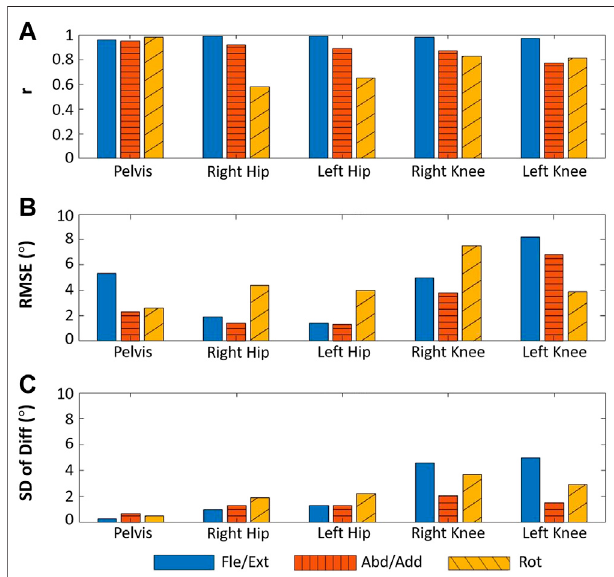
FIGURE 12 | Results for the human subject joint-angle estimation experiment. The blue solid bars denote rotation in the sagittal plane (pelvic tilt, hip Fle/Ext, and knee Fle/Ext), the orange striped bars denote rotation in the frontal plane (pelvic obliquity, hip Abd/Add, and knee Abd/Add), and the yellow diagonally striped bars denote rotation in the transverse plane (pelvic Rot, hip Rot, and knee